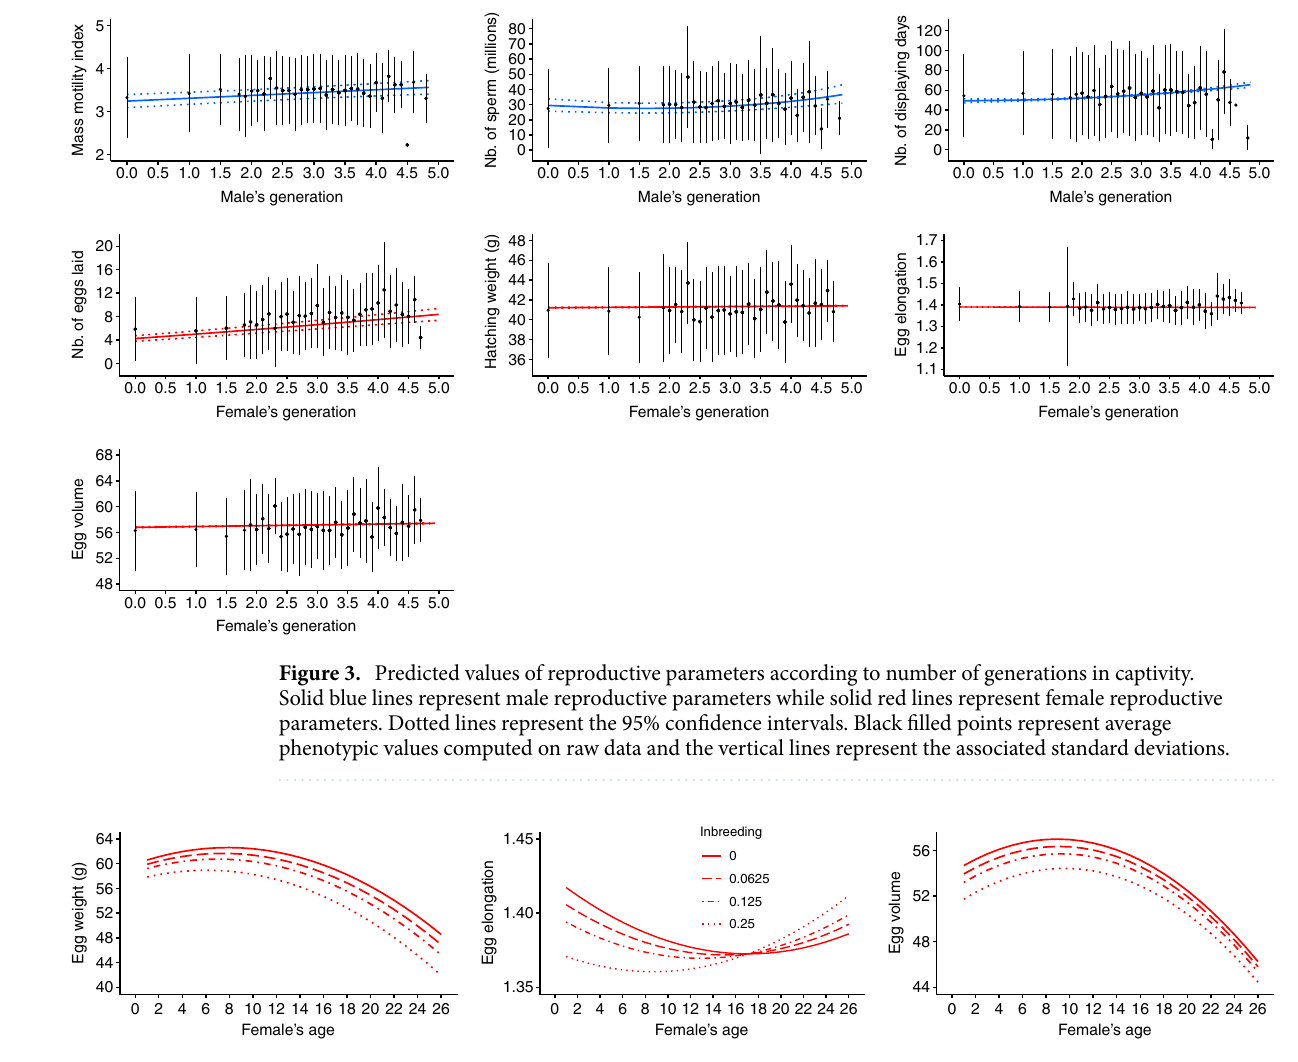
Figure 4. Predicted values of egg weight and egg elongation according to the interaction between age and